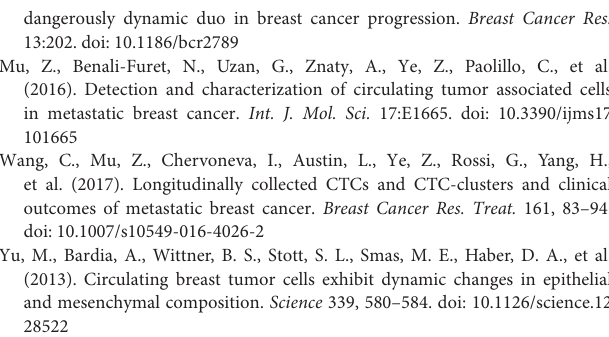
(Ao et al., 2015). Furthermore, CTCs and cCAFs